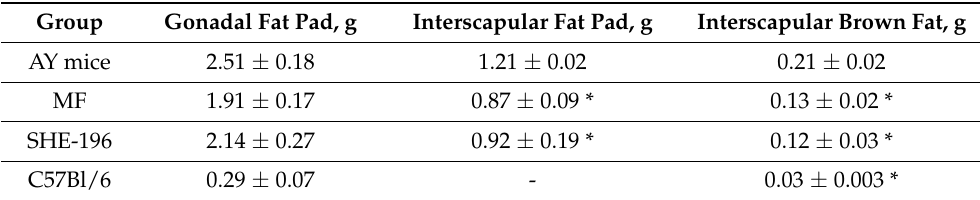
Table 1. Mass of gonadal fat pads, interscapular fat pads and brown fat in AY mice treated for three weeks by SHE-196 at a dose of 15 mg/kg and MF at a dose of 250 mg/kg.